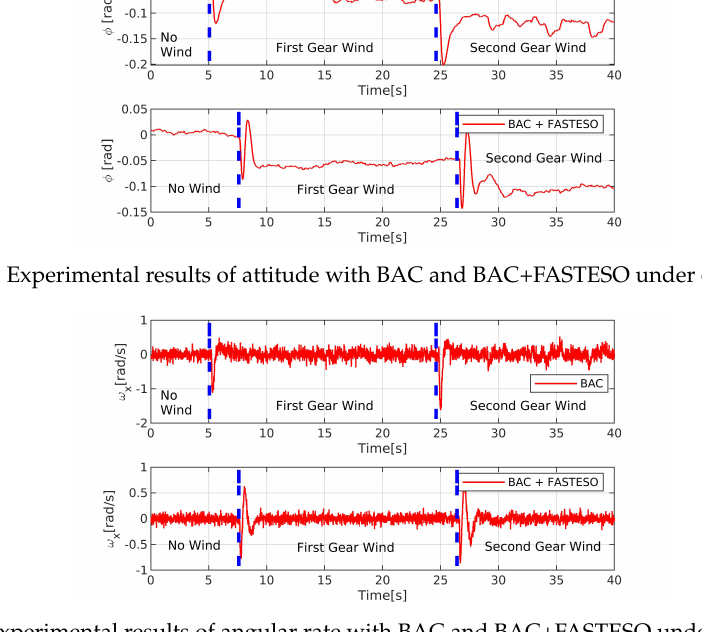
Figure 19. Experimental results of angular rate with BAC and BAC+FASTESO under external wind.